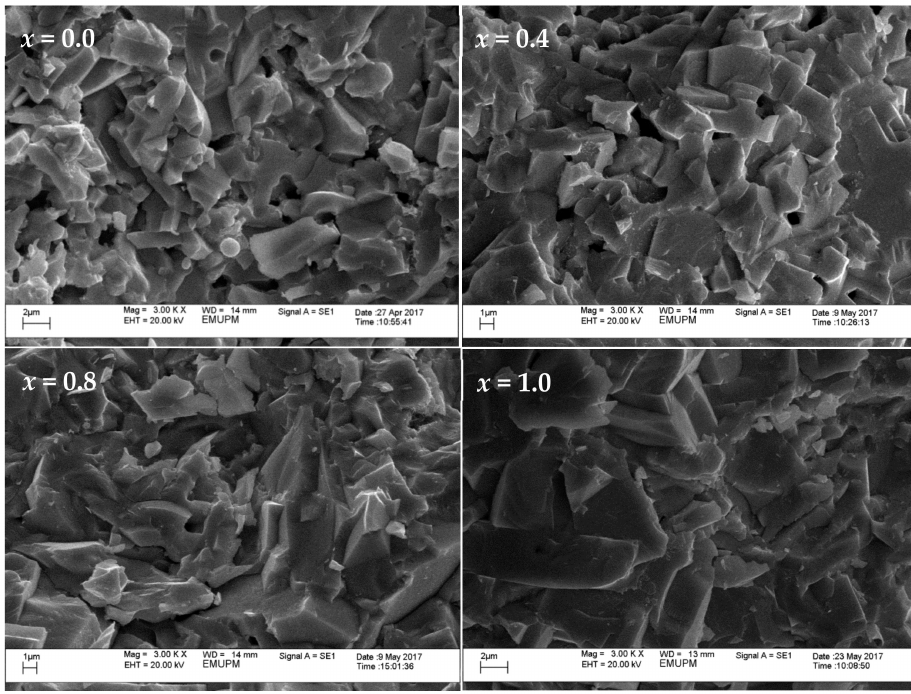
Figure 3. SEM image of Y-123 cross-section at x = 0.0, 0.4, 0.8 and 1.0 SnO 2 addition.